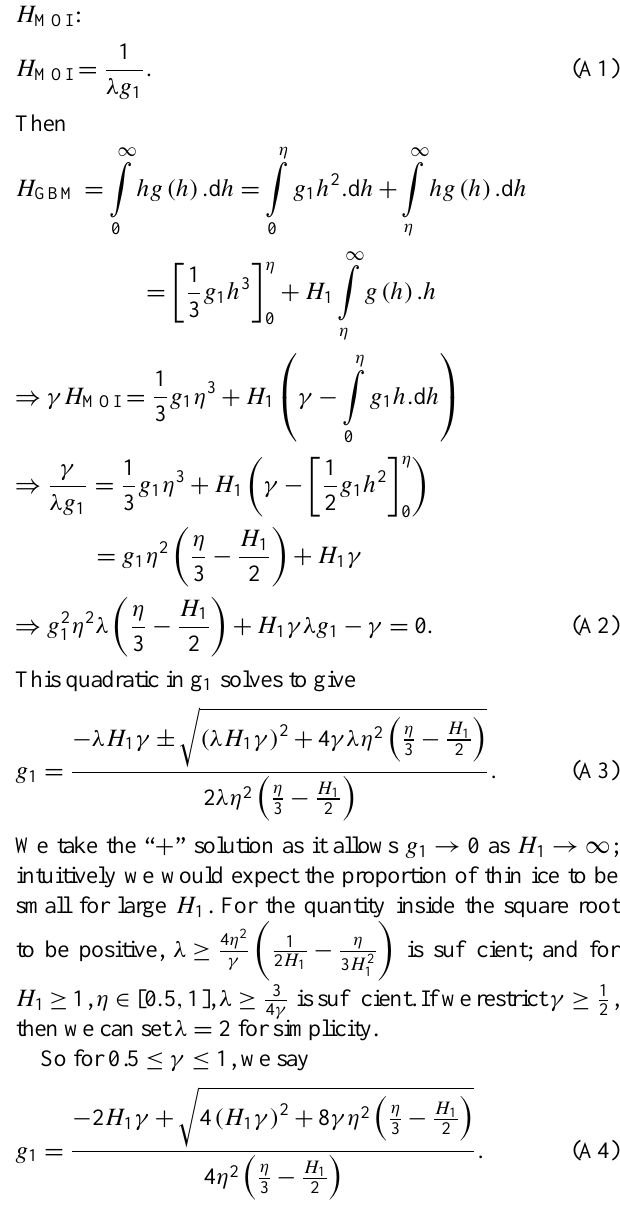
Fig. 10. Time series of monthly mean Arctic sea ice extent anoma- lies from the HadISST dataset, 1981–2000. Anomalies are taken relative to the 1981–2000 mean extent for each respective